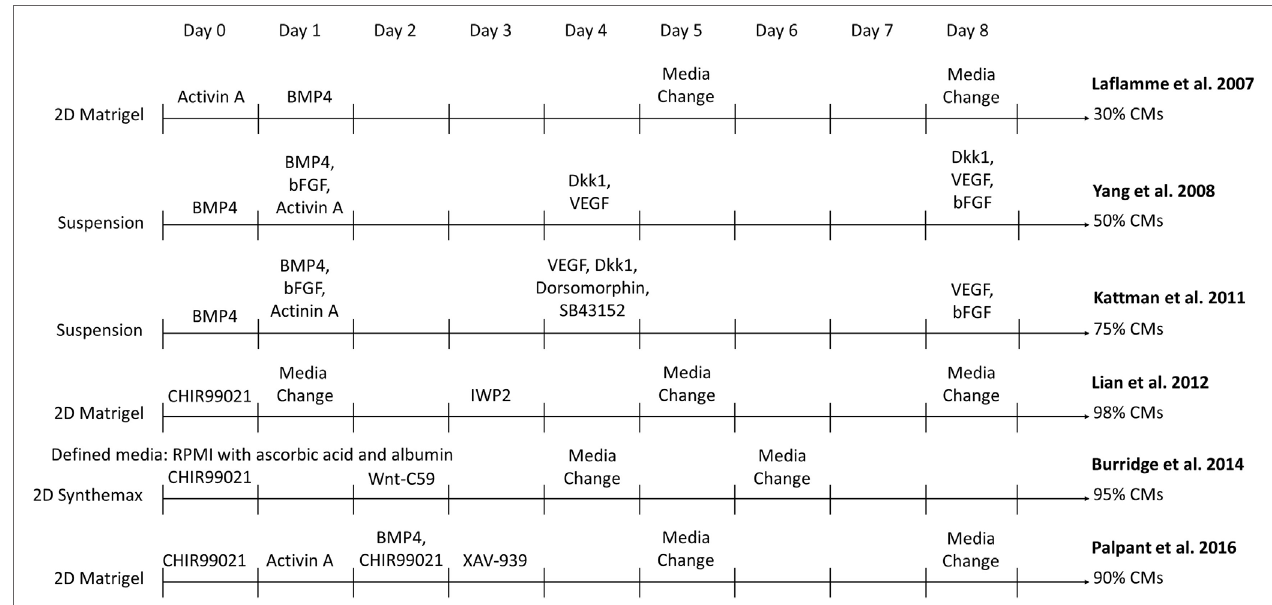
FiGURe 1 | Comparison of select directed differentiation protocols for differentiating human pluripotent stem cells to cardiomyocytes